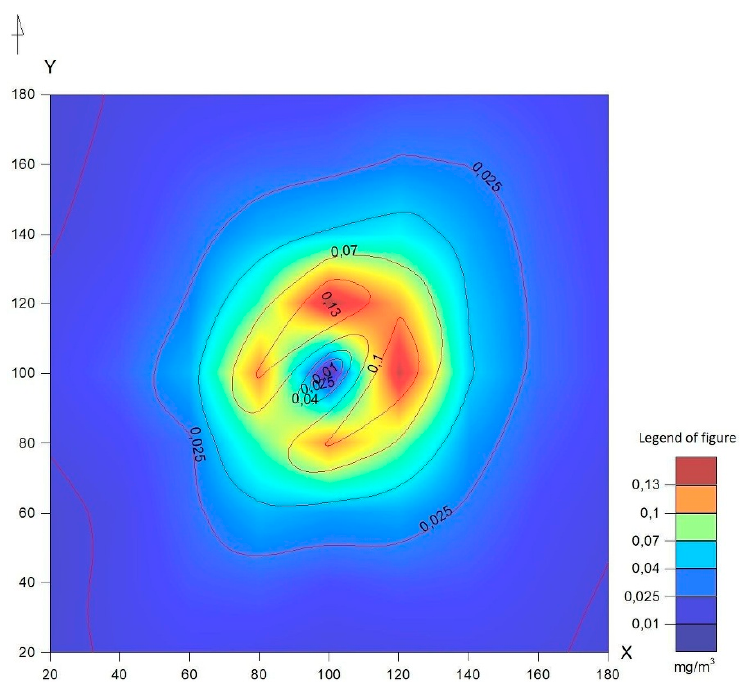
Figure 1. Maximum concentrations for methane (CH 4 ) emissions at a height of 10 m. Note: X axis—component of the distance from the emitter to the point for which the calculations were made, parallel to the wind direction; Y axis—component of the distance from the emitter to the point for which the calculations were made, perpendicular to the wind direction.